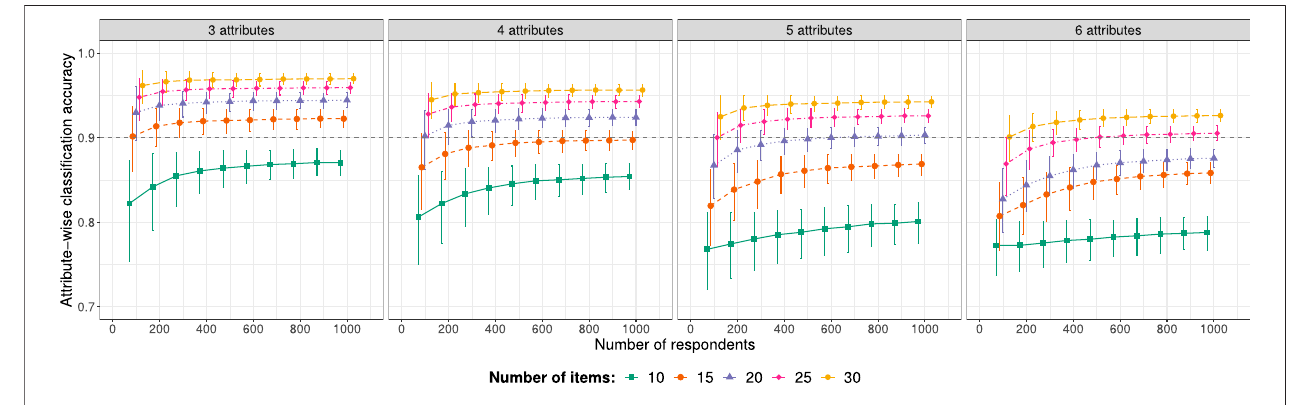
FIGURE 1 | Average marginal classi fi cation accuracy (with 90% error bars) in the conditions resulting from crossing the number of attributes A , items I , and respondents R forwhichthegeneratingmodelwasconsistentwiththeestimatedmodel.Verticalaxesstartat0.7forclearerpresentationofresultsandhorizontaldashed lines indicate accuracy of 0.9.